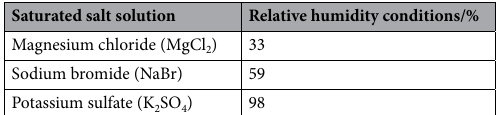
Table 1. Saturated salt solution and relative humidity